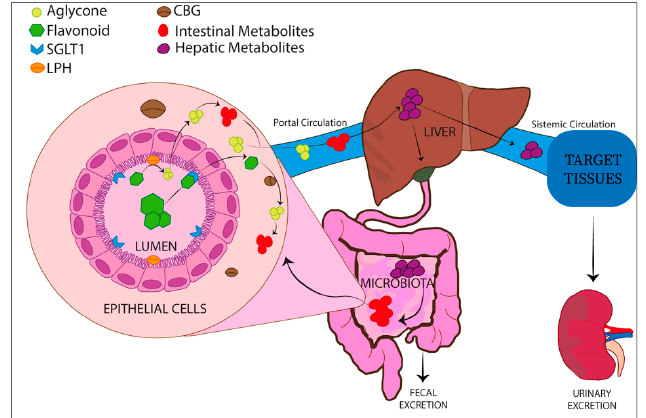
Figure 2. Schematic overview of flavonoid metabolism, showing the uptake and the modifications of the flavone in the different districts/organs. Sodium-glucose co-transporter type 1 (SGLT1), cytosolic β -glucosidase (CBG), lactase-phlorizin hydrolase (LPH).